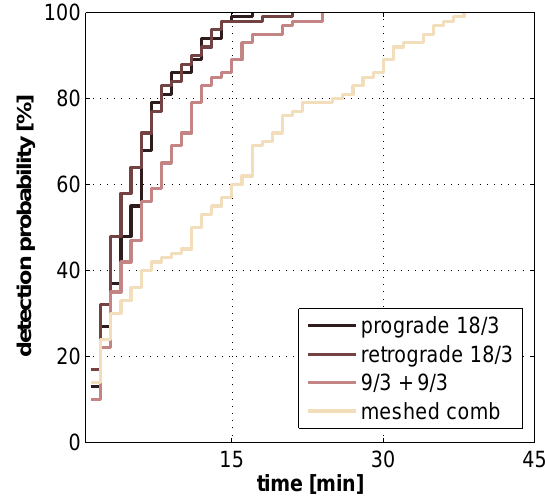
Fig. 8. Tsunami detection probabilities of the same four constella- tions as in Fig. 3 when applied to the Sumatra tsunami using GPS, GLONASS and Galileo reflections as signal